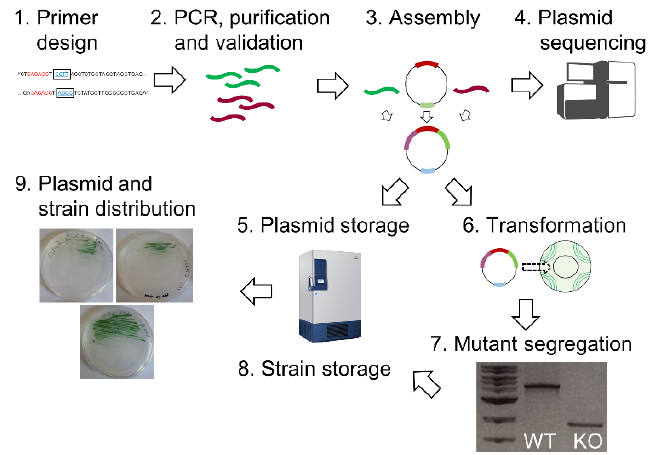
Figure 5. Workflow for the automated production of the CyanoSource resource at two UK DNA Foundry facilities. Primers ( 1 ) will be used to generate amplicons carrying BsaI sites (red) and appropriate four-nucleotide overhangs (blue, boxed) for MoClo assembly. PCR products will then be purified and validated ( 2 ) and used to assemble suicide vectors ( 3 ) for natural transformation of Synechocystis sp. PCC 6803. Vectors will be sequenced by MiSeq ( 4 ) and glycerol stocks made for long-term storage ( 5 ). PCC 6803 mutants will be generated ( 6 ), followed by several rounds of re-streaking to produce segregated mutants that will be confirmed by colony PCR ( 7 ), and stored as glycerol stocks ( 8 ). For distribution, plasmid stocks are planned to be supplied by Addgene and mutants supplied by the University of East Anglia CyanoSource Hub as streaked plates from glycerol stocks ( 9 ).